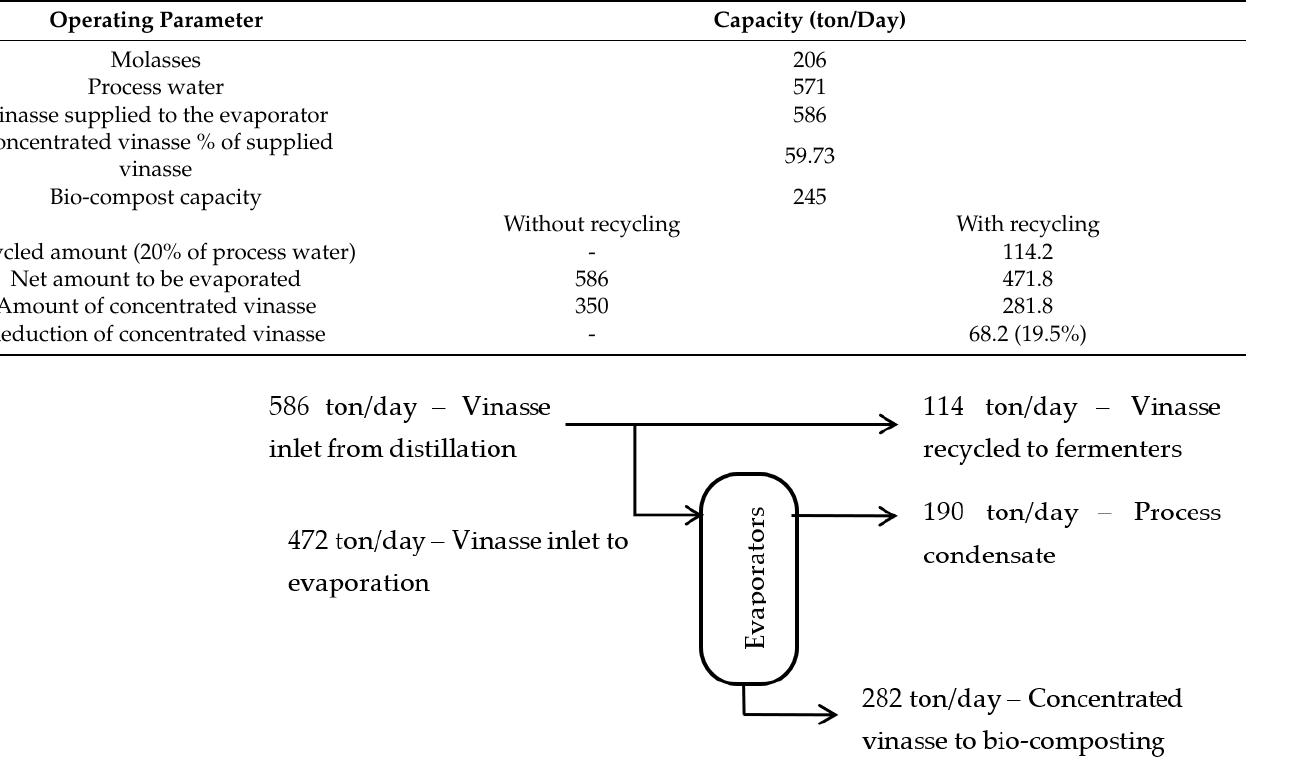
Figure 3. Mass balance of the evaporation plant with vinasse recycling.